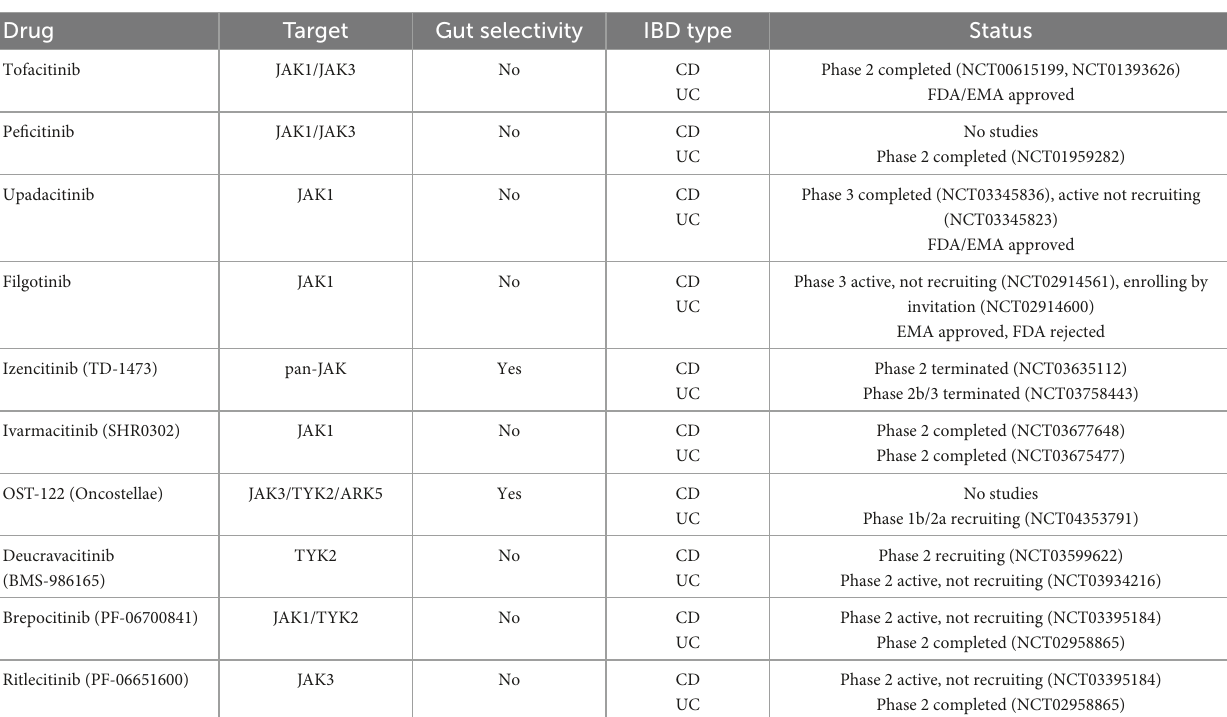
TABLE 1 JAK inhibitors approved or in current development for